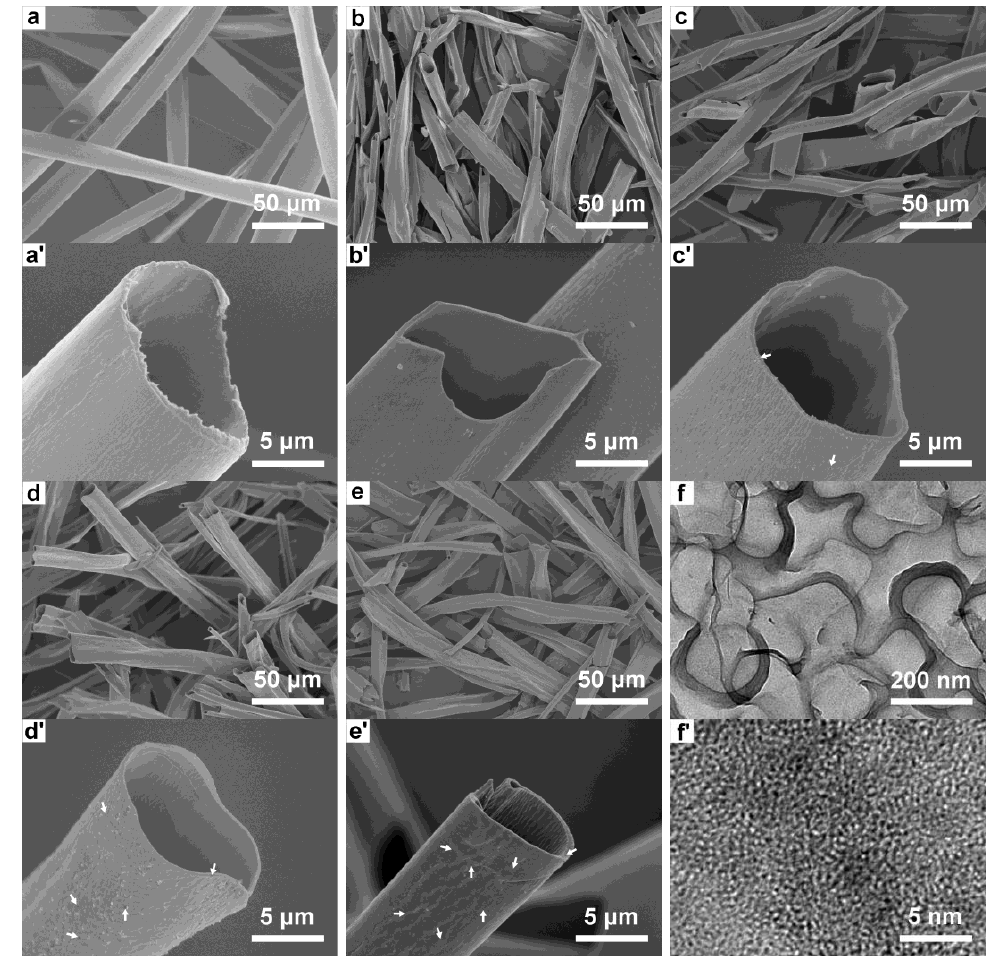
Figure 3. SEM images of ( a and a ’ ) KF, ( b and b ’ ) CKF-500, ( c and c ’ ) CKF-600, ( d and d ’ ) CKF-700, and ( e and e’ ) CKF-800; ( f and f ’ ) TEM image of CKF-800.